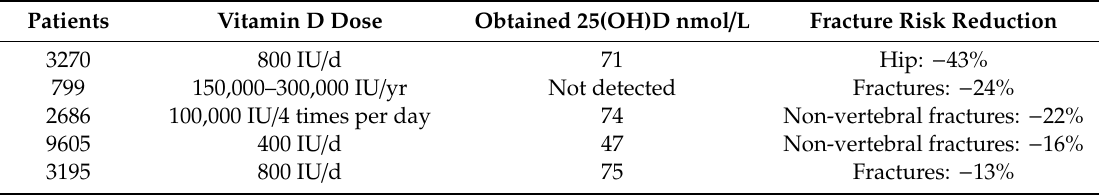
Table 3. Fracture risk reduction in patients receiving vitamin D